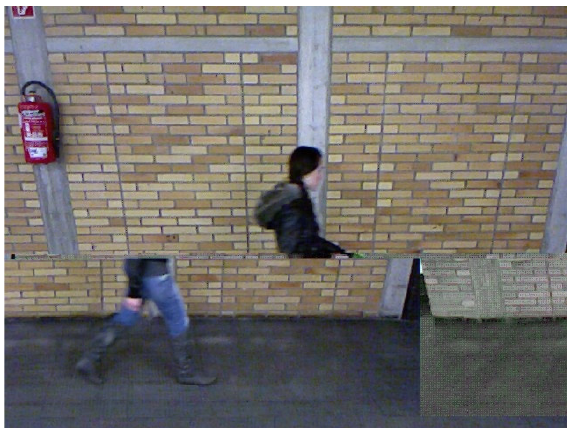
Figure 3. Misaligned image [1].